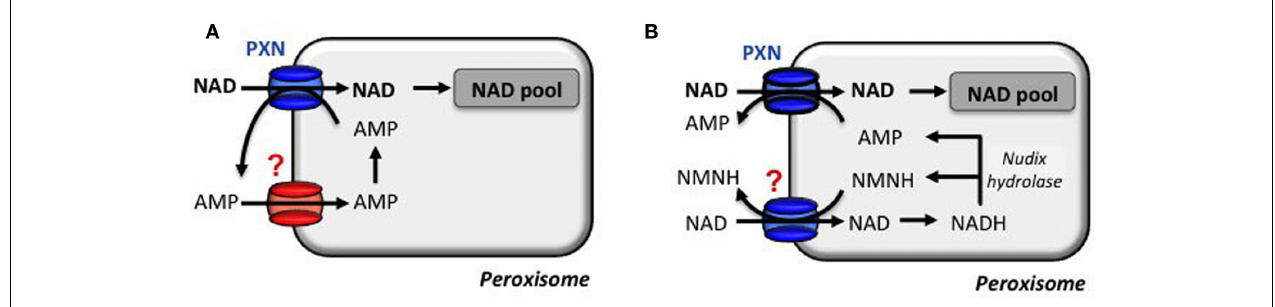
peroxisomal Nudix hydrolase is postulated to degrade NADH to AMP and reduced nicotinamide mononucleotide (NMNH). Both function as a counter-substrate and deliver a net import of NAD. A NMNH/NAD carrier has not been described and NMNH has not been tested for PXN (N. Linka, personal